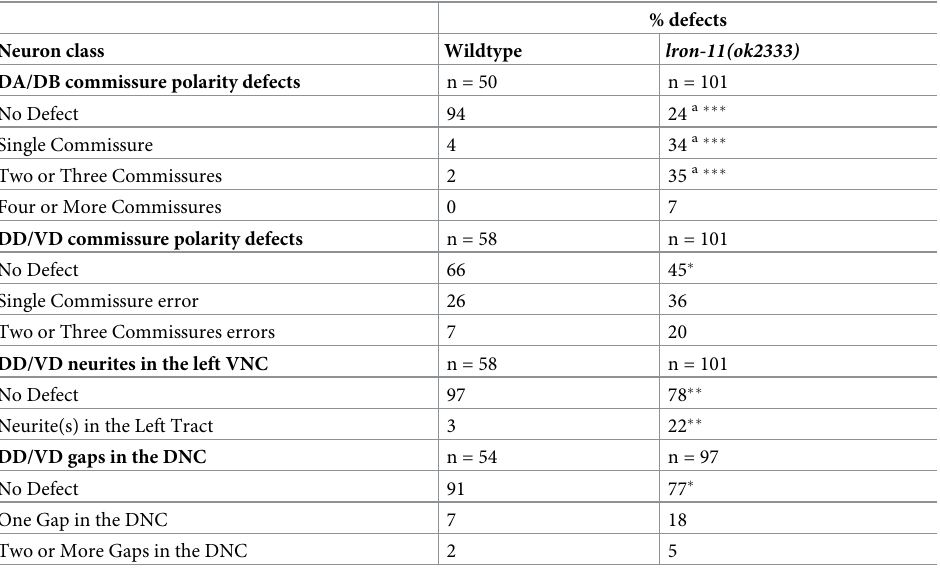
Table 3. Motoneuron axon guidance defects in lron-11